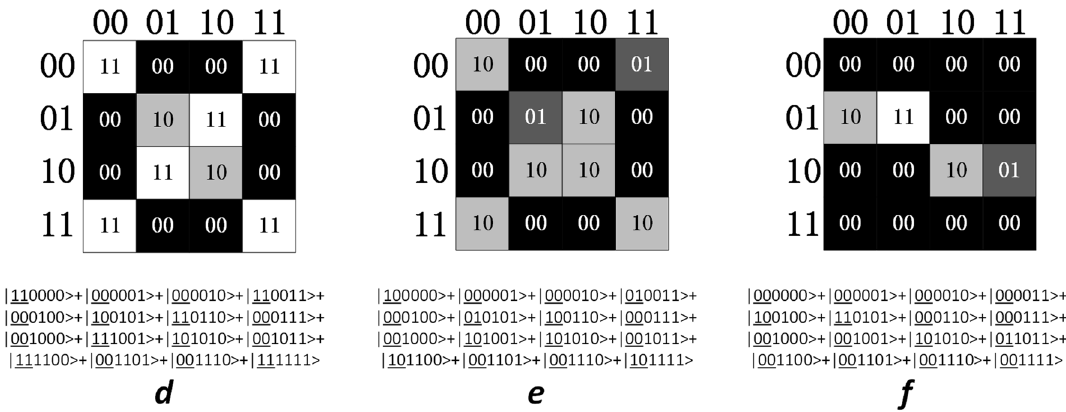
Figure 6. Three grey images used for calculating similarities. The image representation states are shown below the images. The pixel value qubits are underlined. Probability amplitudes are not given for simplification.